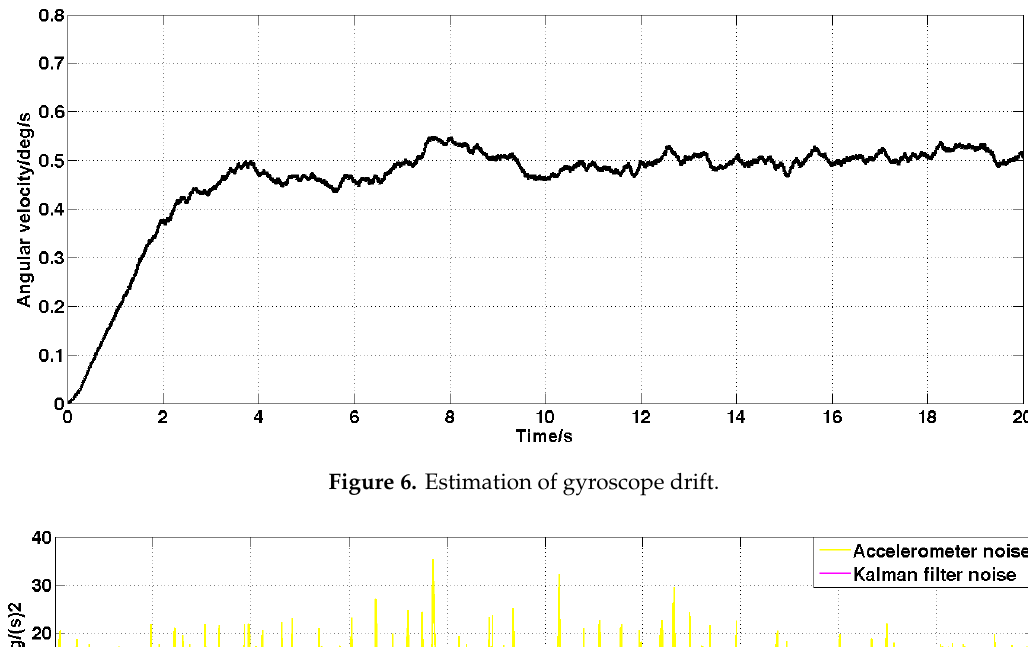
Figure 5. The angular velocity signal after filtering by the Kalman algorithm.